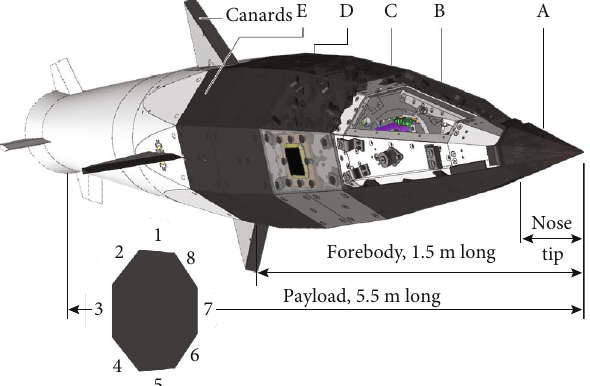
Figure 1: Sharp-edged fl ight experiment SHEFEX II.